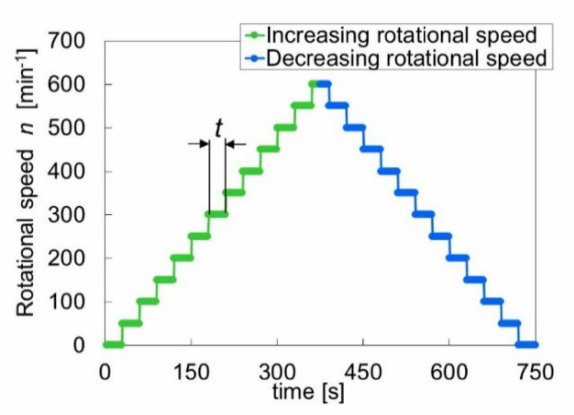
Figure 5. Control of the rotational